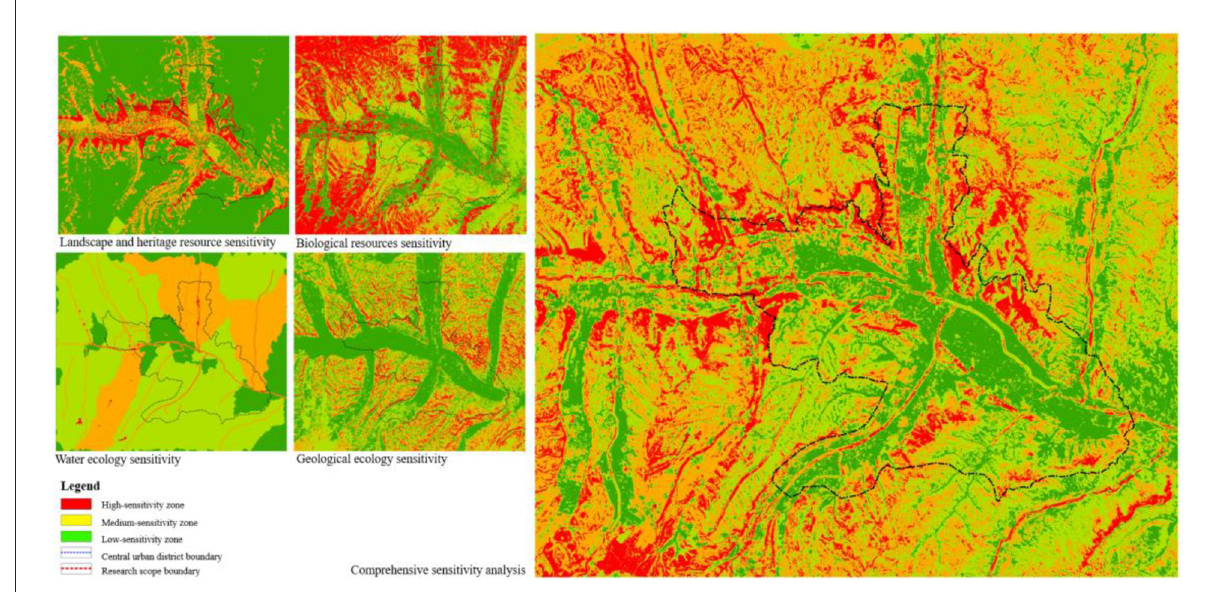
FIGURE5 Comprehensive ecological sensitivity analysis of central urban districts in Xining.